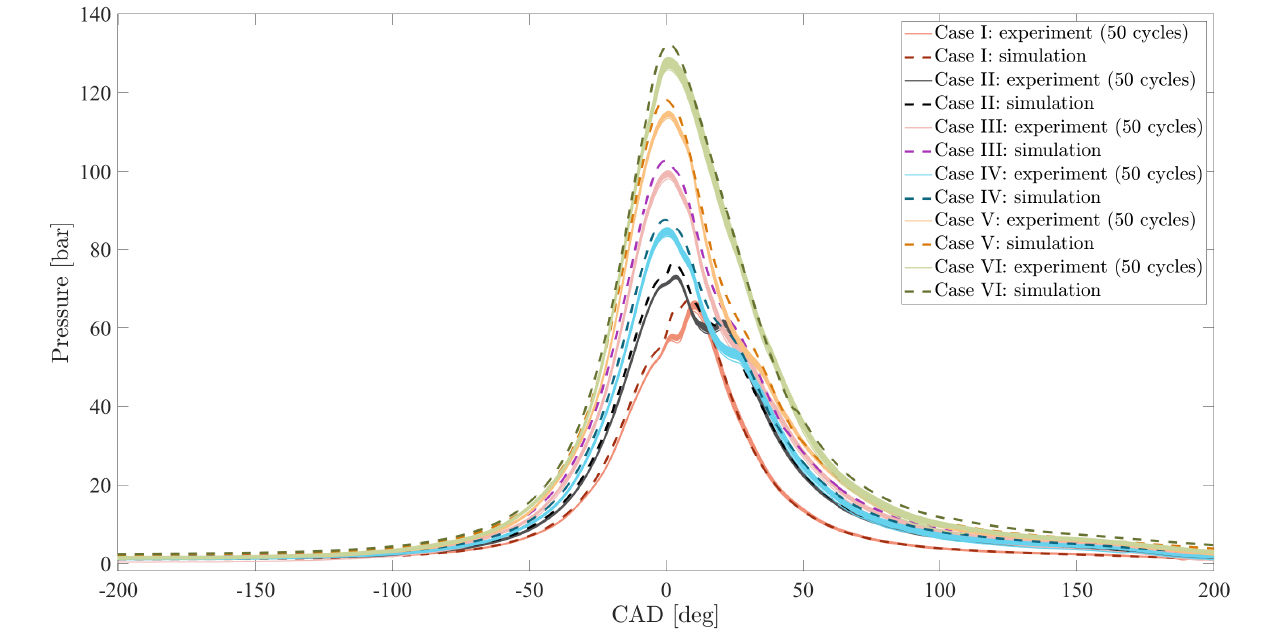
Figure 5. Physical–based model validation for six operating points. (Case I: 136 [ N.m ] in 1200 [ rpm ] , Case II: 271 [ N.m ] in 1600 [ rpm ] , Case III: 271 [ N.m ] in 1400 [ rpm ] , Case IV: 271 [ N.m ] in 1800 [ rpm ] , Case V: 271 [ N.m ] in 2000 [ rpm ] , and Case VI: 353 [ N.m ] in 2400 [ rpm ]